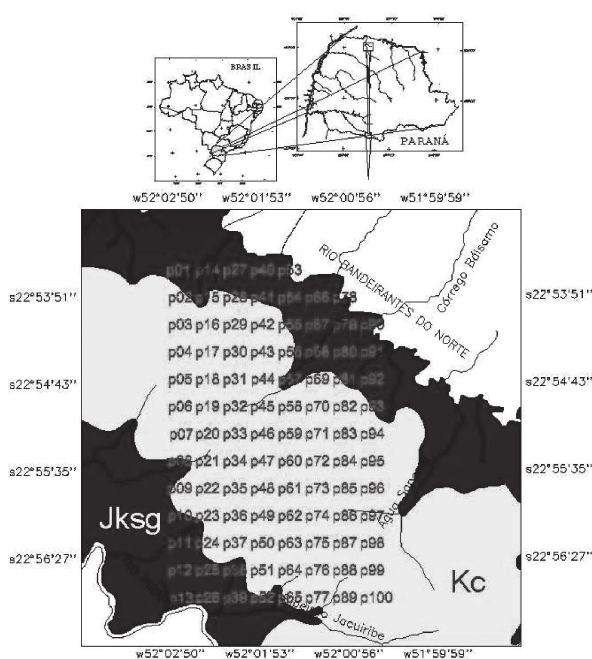
Figura 1. Área de estudo representando o grid de amostragem e a geologia local, em que JKsg: Formação Serra Geral; e Kc: Grupo